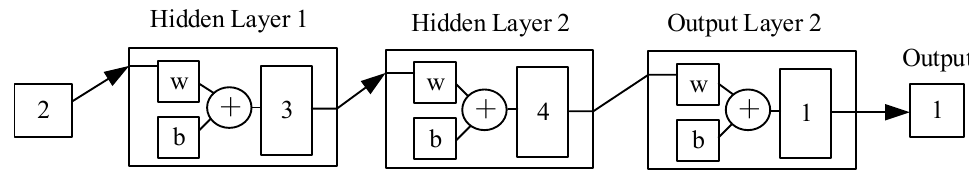
Figure 21. The structure of the CPB strength prediction model under the influence of different temperatures.